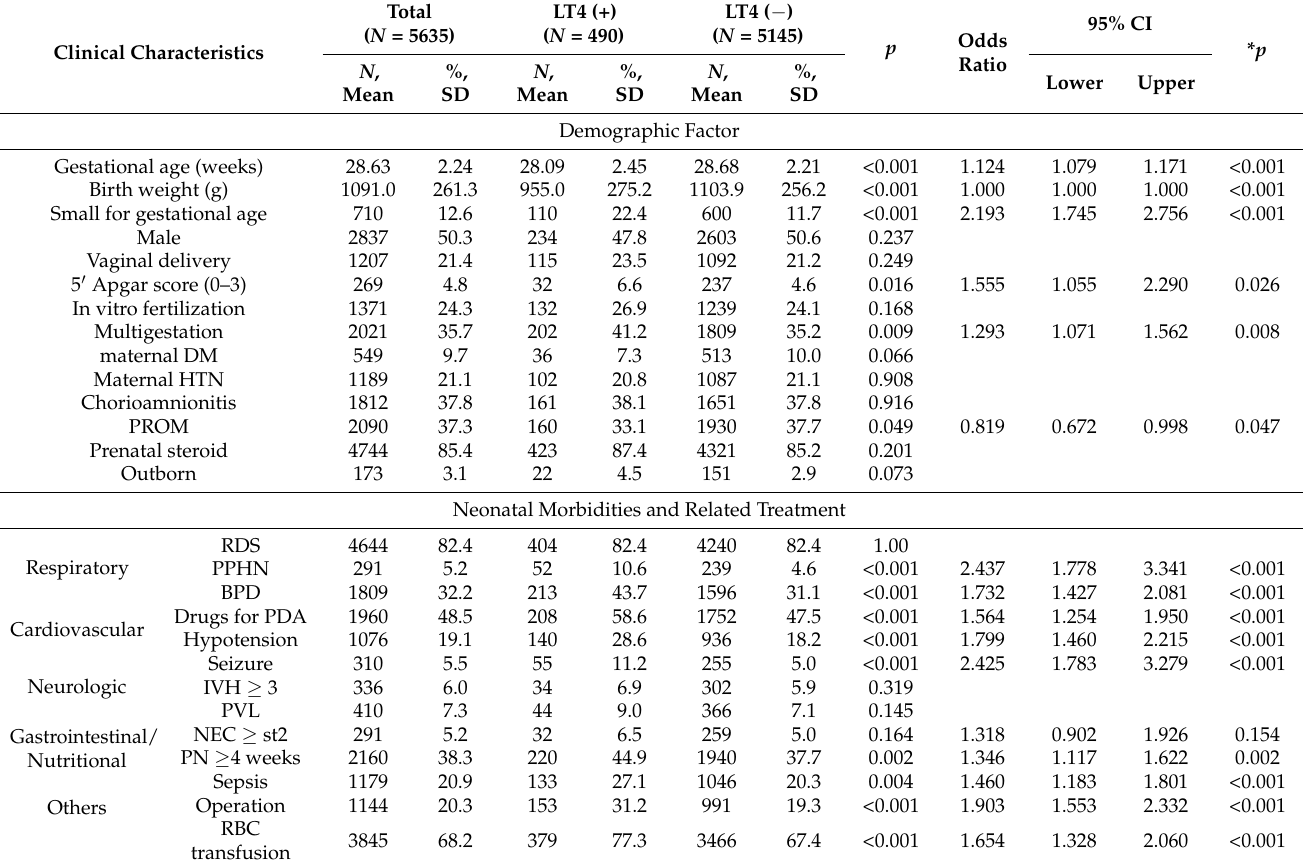
Table 1. Comparison and risk analysis of clinical characteristics in very low birth weight infants according to L-thyroxine administration for thyroid